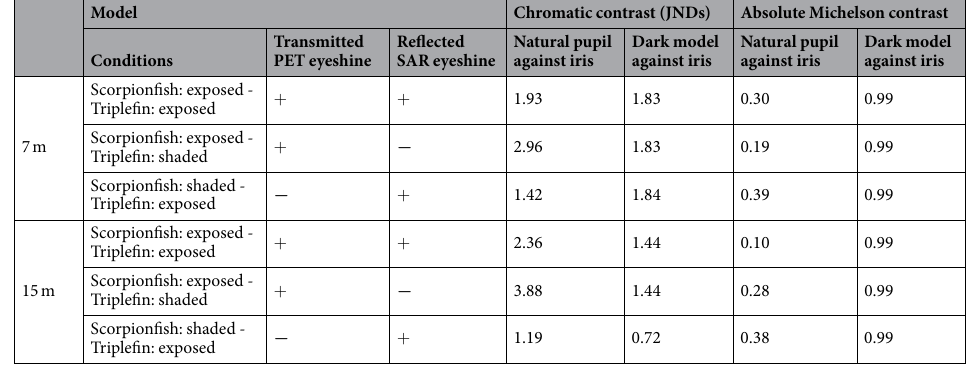
Table 2. Estimated chromatic and achromatic contrast in the eye of a scorpionfish. Chromatic contrast values in just-noticeable-differences (JNDs) are calculated between the natural pupil (with eyeshine), the model pupil (without eyeshine) and the iris for three light scenarios (described by rows 1–3) at two depths. Achromatic contrast values are expressed as absolute Michelson contrasts between the same three structures. All contrasts are calculated from the perspective of the triplefin Tripterygion delaisi , a common prey species. SAR eyeshine refers to “broad-sense” SAR eyeshine. See Material and Methods and Table S1 for details.